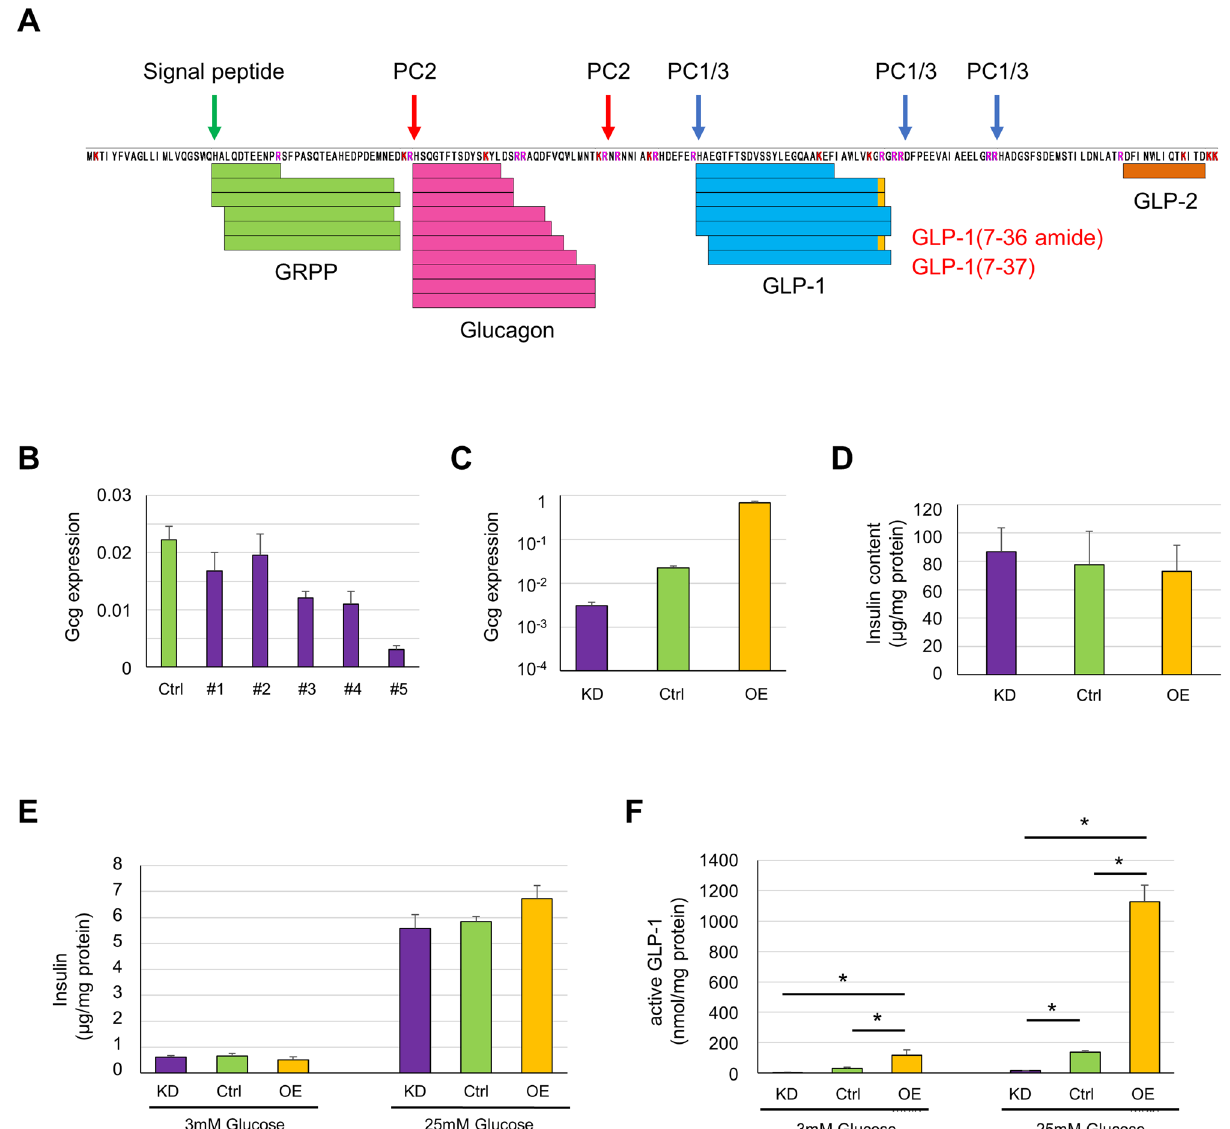
Figure 2. MIN6-CB4 cells with elevated and reduced expression of the Gcg gene were produced. ( A ) Mass spectroscopic analysis of preproglucagon proteolytic processing in MIN6-CB4 cells. Peptide-rich